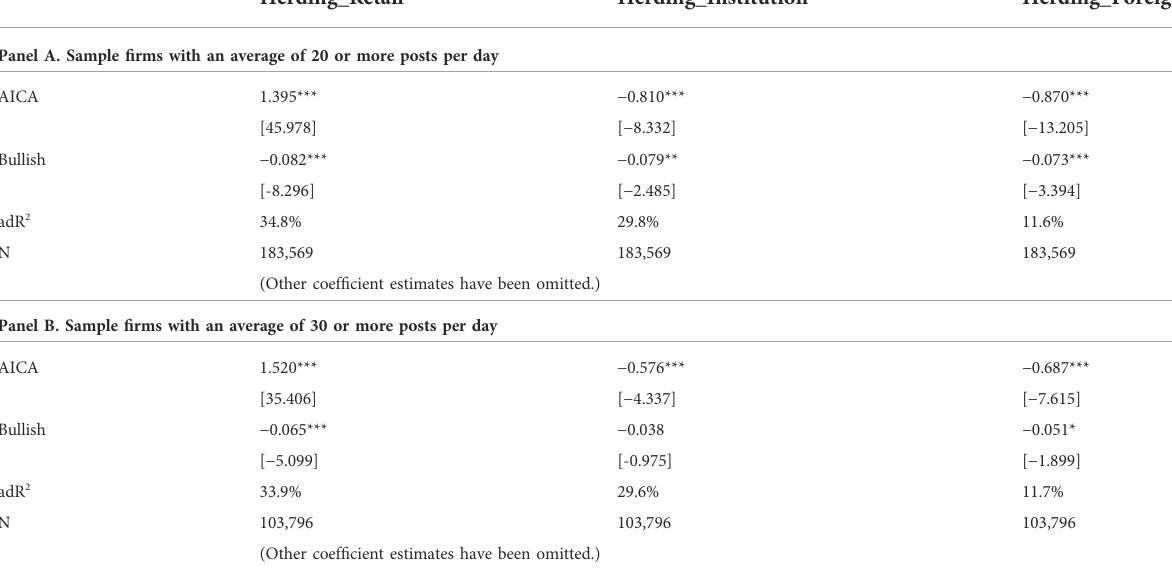
TABLE 5 Robustness tests of subsample groups. Table reports robustness tests of sub samples, applying sample fi rms with an average of 20 or more posts per day (Panel A) and sample fi rms with an average of 30 or more posts per day (Panel B). This table presents the parameter when we